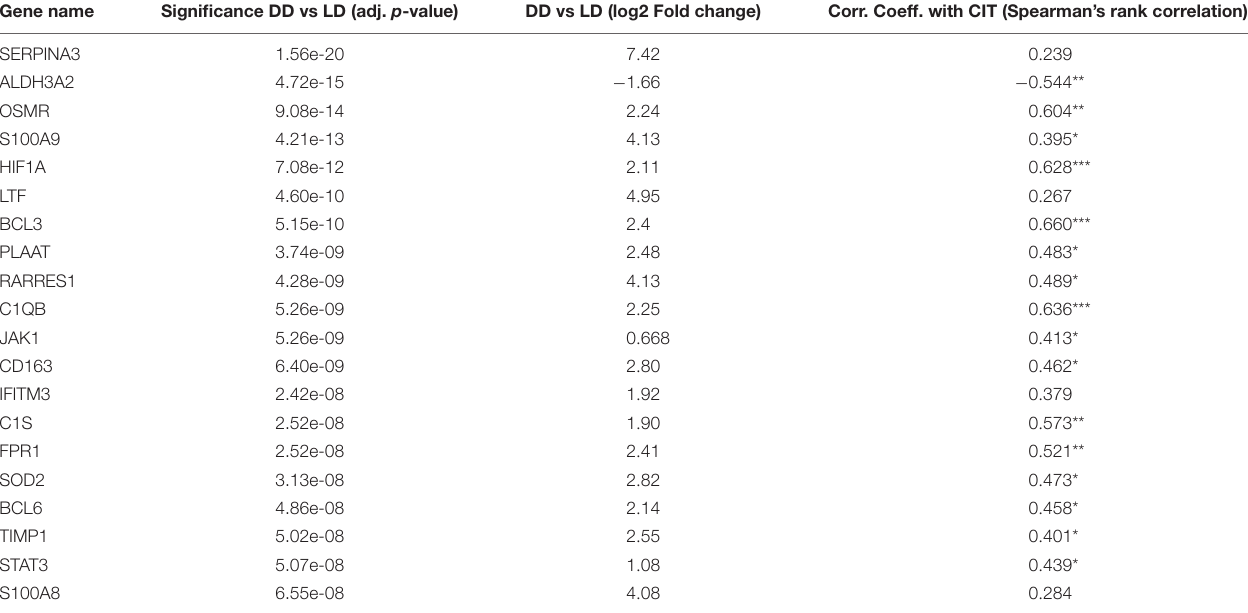
TABLE 3 | Correlation of the top 20 differentially expressed genes between deceased (DD) and living donors (LD)with cold ischemia time (CIT).